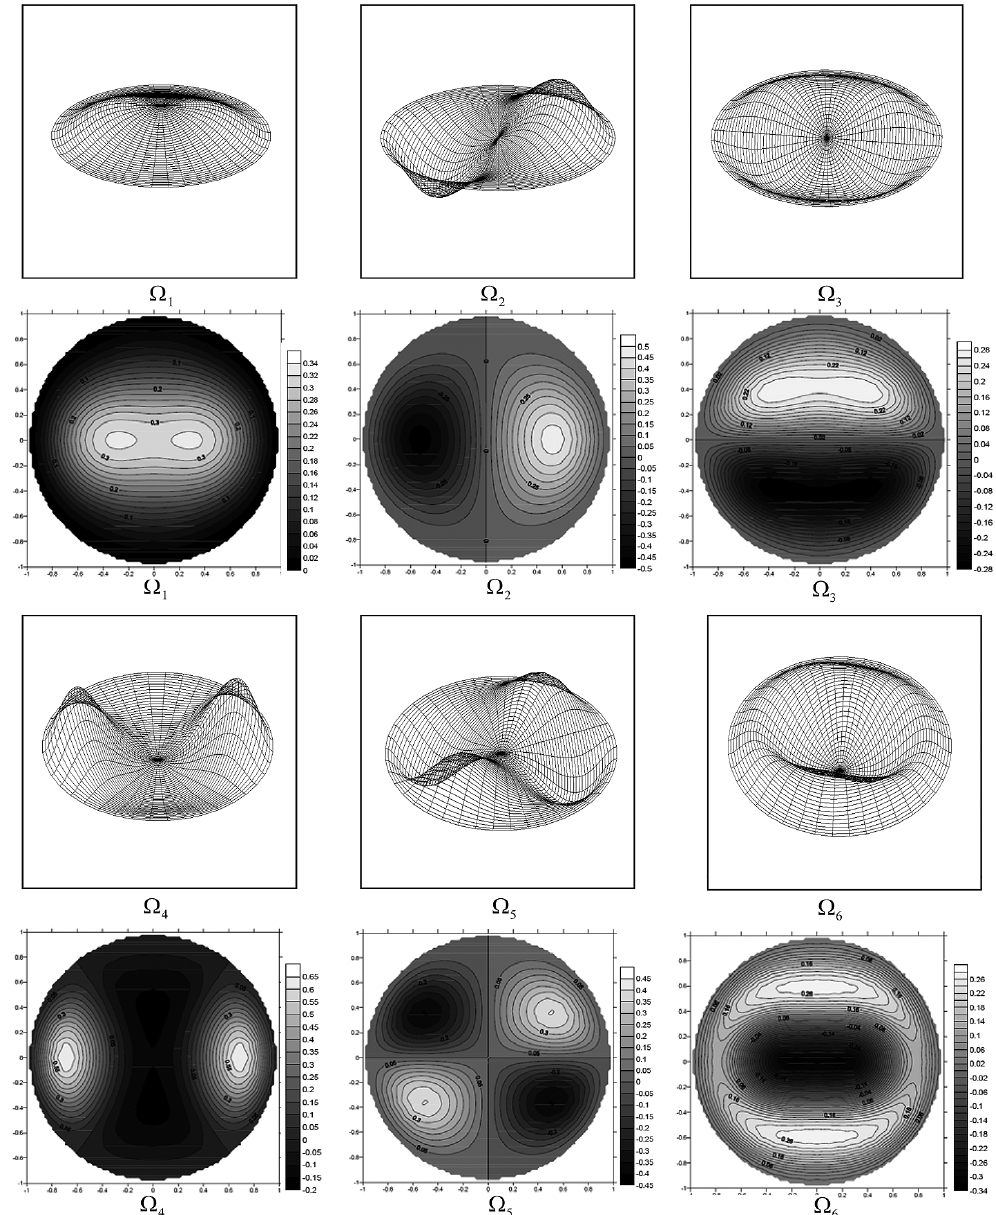
Fig. 6. First six normal modes and their contours for C-plates when α = β = 0.5 and k =